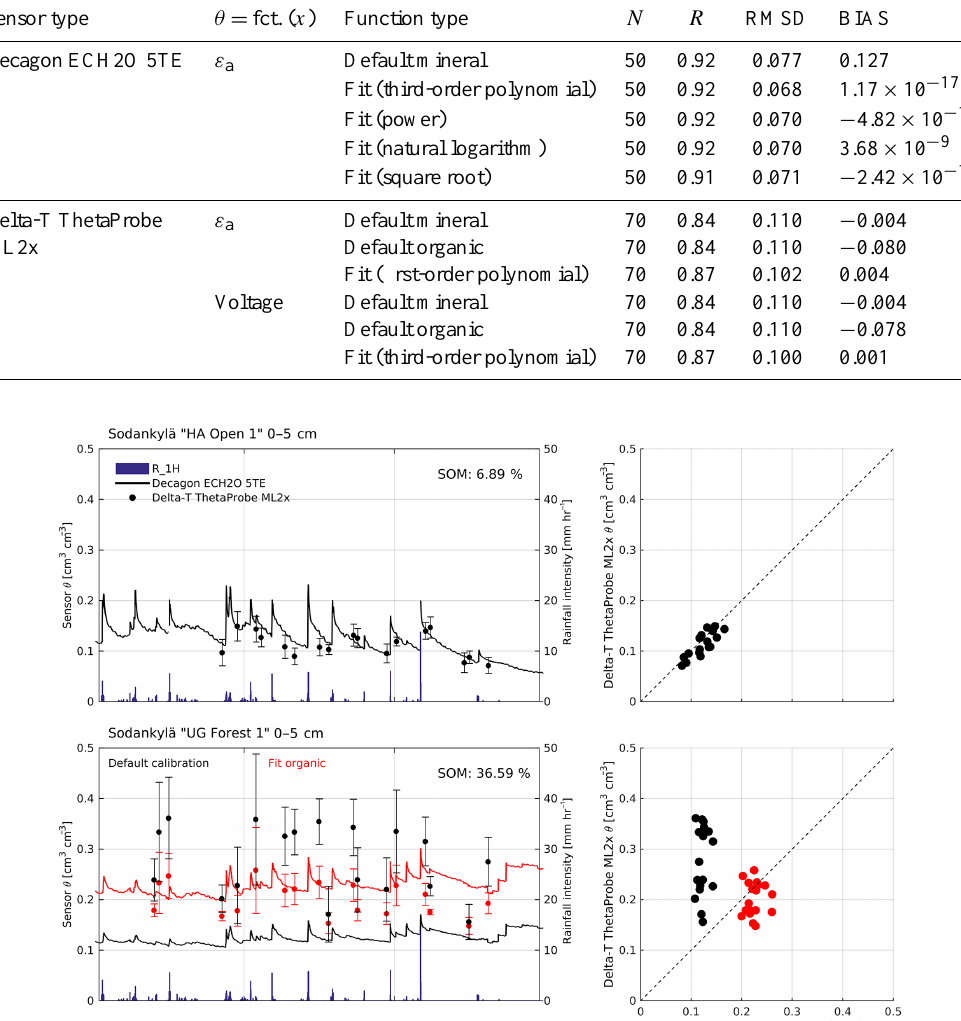
Figure 5. Time series (left column panels) and scatter plots (right panels) for the soil moisture ( θ ) measured at 0–5cm depth by ThetaProbe (average of five readings with standard deviations as error bars) and Decagon 5TE sensors at the Sodankylä “HA Open 1” (upper row panels: low organic mineral soil, SOM = 6.89%) and “UG Forest 1” (lower row panels: organic substrate, SOM = 36.59%) network stations during summer 2012. Hourly rainfall intensities (R_1H) from Tähtelä are plotted along. Details on the applied calibration functions (default in black and newly derived in red) as well as corresponding statistics are given in Table